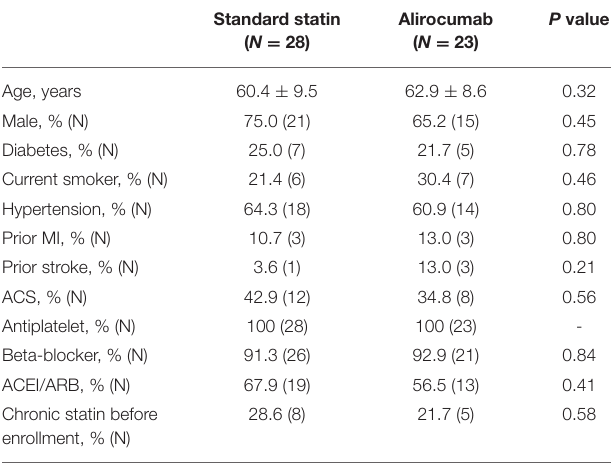
TABLE 1 | Baseline characteristics. TABLE 2 | Biochemical